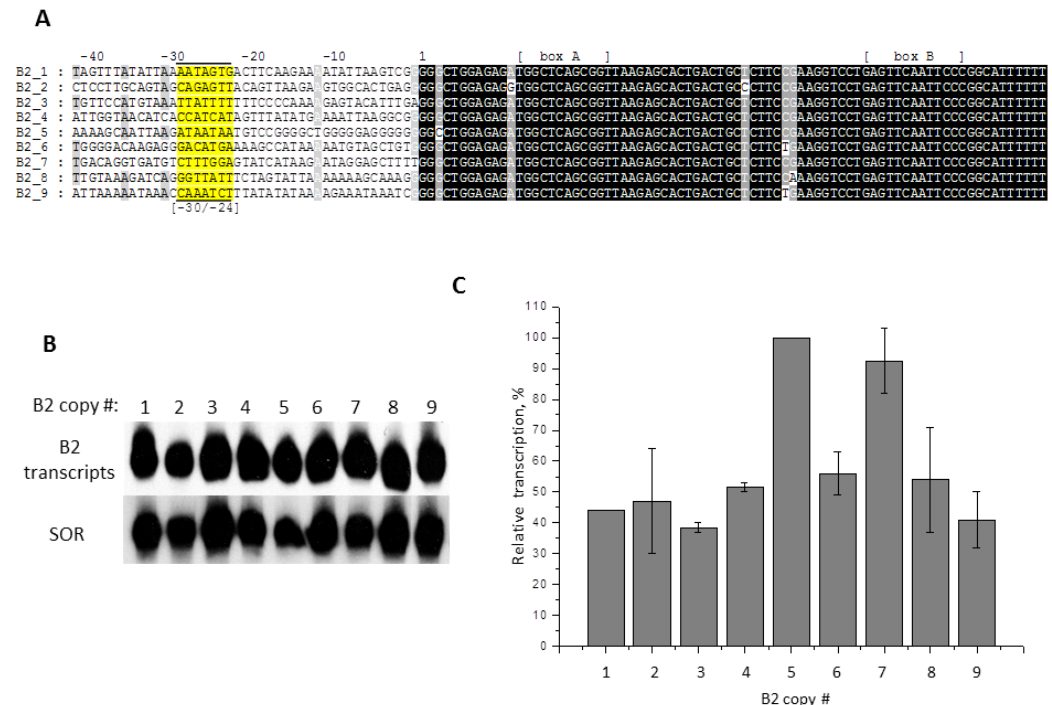
Figure 9. Transcription of nine similar B2 SINE copies from murine genome introduced into HeLa cells. ( A ) Nucleotide sequences of the 3 ′ -truncated B2 copies (mini-B2) with their 5 ′ -FSs. Boxes A and B of pol III promoter and –30/–24 sequences are labeled. ( B ) Mini-B2 transcripts detected by Northern hybridization in the transfected cells. The numbers of B2 copies are indicated above the lanes. ( C ) Quantitative analysis of Northern hybridization data. B2_5 transcription level is taken as 100% (error bars, SD, n = 3).